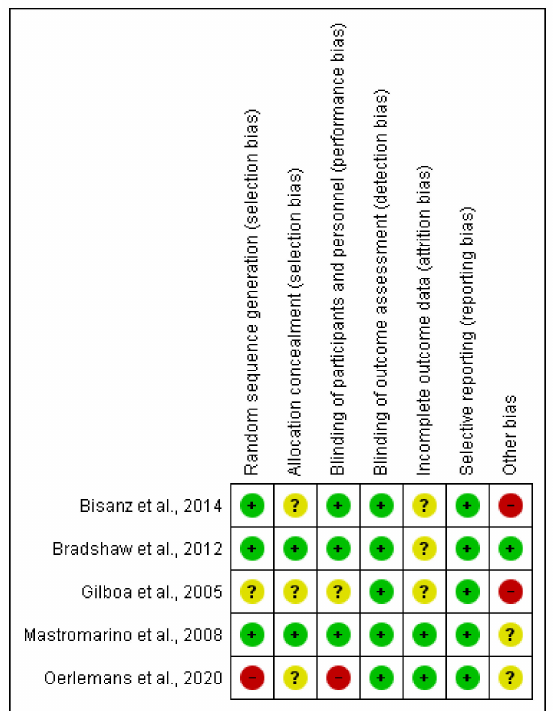
Figure 4. Risk of bias summary of CT: authors’ judgments about each risk of bias item for each included study low risk (+, green circle), high risk ( − , red circle), or unclear risk (?, yellow